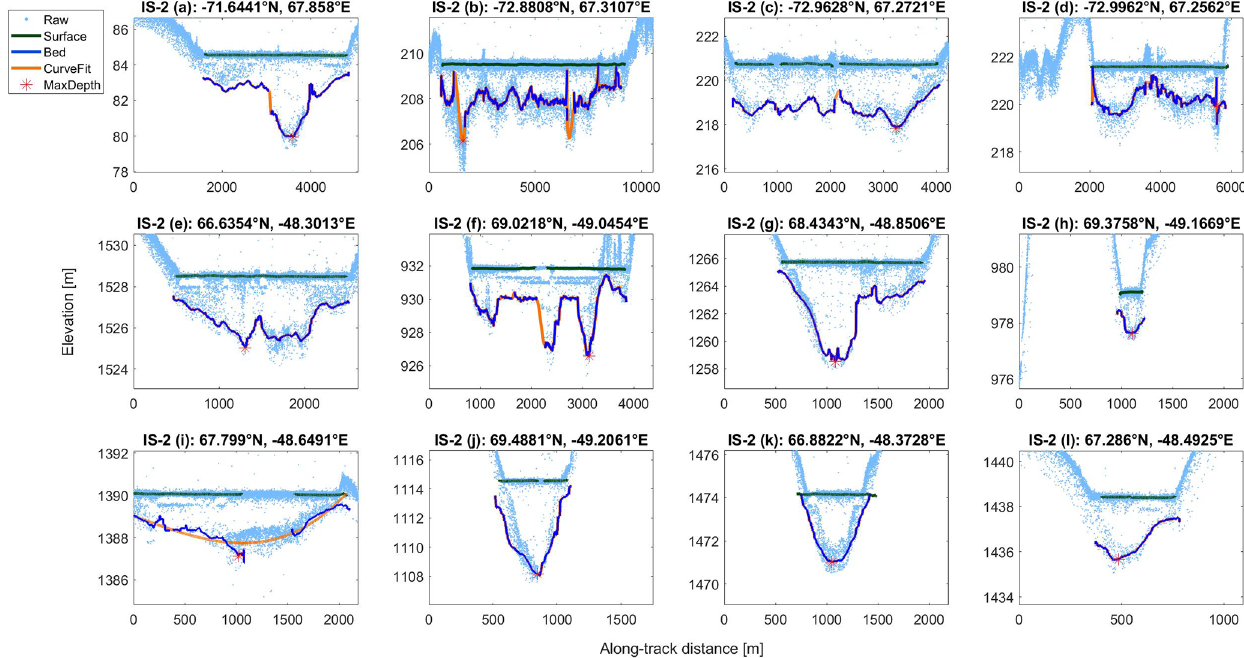
Figure 4. Supraglacial lakes and melt ponds detected by ICESat-2 over the Amery Ice Shelf (a–d) and western Greenland (e–l) , using Tracks 0081 and 1222,